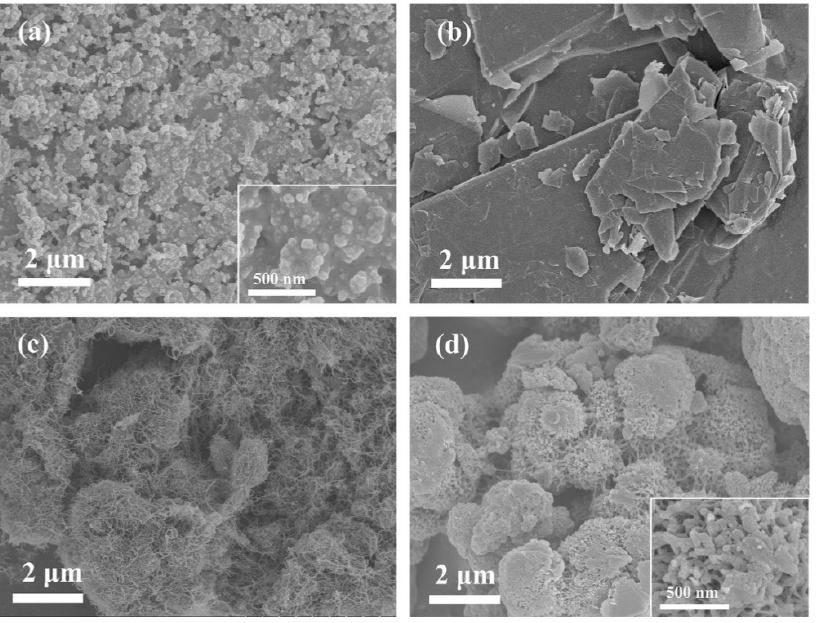
Figure 2. SEM images of the four different conductive additives: ( a ) CB; ( b ) CG; ( c ) MWCNT; ( d ) PANI.